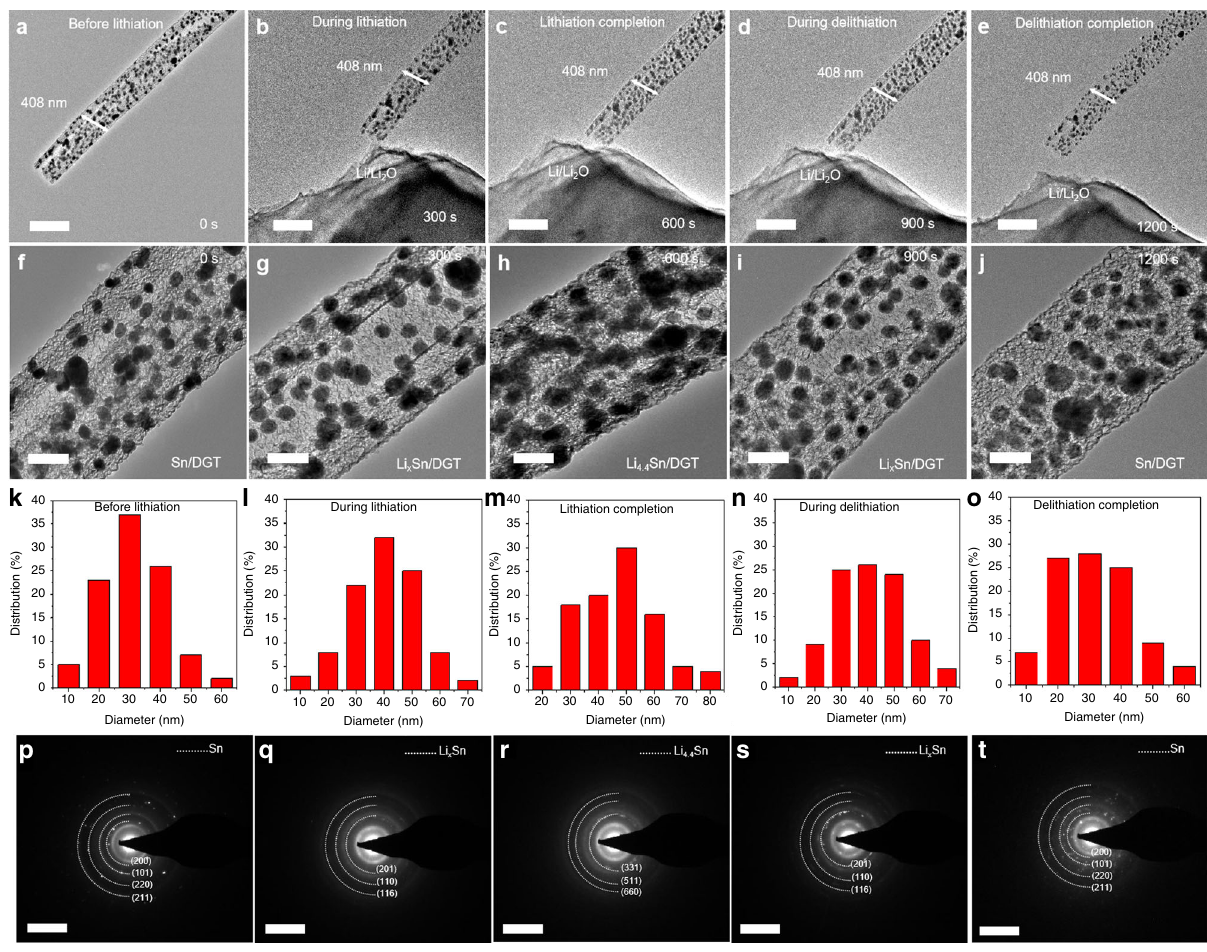
Fig. 5 In situ TEM observation of Sn/DGT during a lithiation-delithiation cycle. a – e Time-lapse low magni fi cation and f – j high-magni fi cation TEM images showing the lithiation and delithiation of a Sn/DGT electrode (Supplementary Movies 1, 2). During this process, the Sn nanoparticles experienced volume expanding and shrinking, yet remained within the graphene tube, of which the structure and dimension remains unchanged. Scale bars: a 500 nm; b 500 nm; c 500 nm; d 500 nm; e 500 nm; f 100 nm; g 100 nm; h 100 nm; i 100 nm; j 100 nm. k – o Size analysis of the Sn nanoparticles during the lithiation-delithiation cycle obtained using a semi-automated sizing approach. p – t The selective area electron diffraction patterns of the Sn nanoparticles during the lithiation-delithiation cycle. Scale bars: p 5 1/ nm; q 5 1/nm; r 5 1/nm; s 5 1/nm; t 5